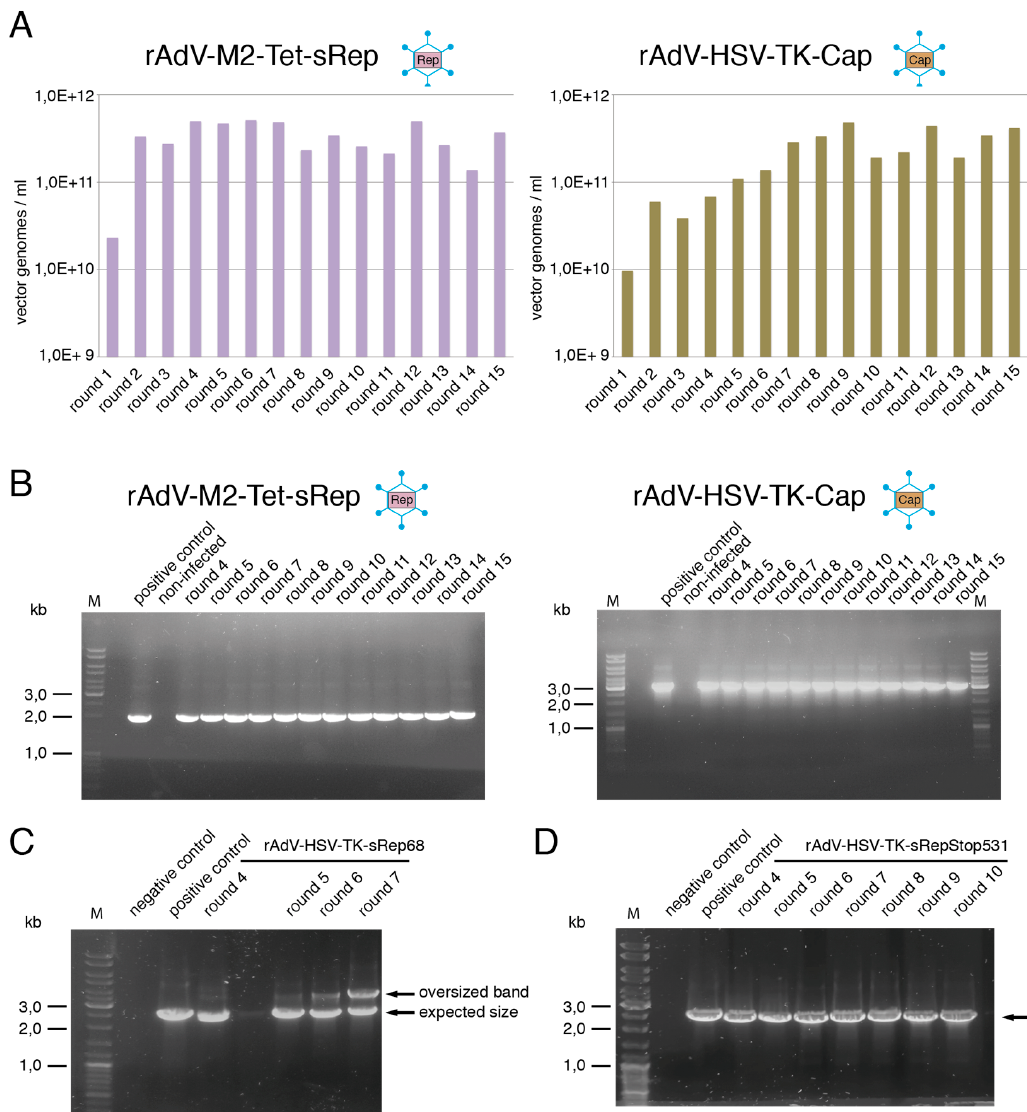
Figure 7. Genomic stability of rAdV used in rAAV packaging. ( A ) and ( B ) rAdV-M2-Tet-sRep and rAdV-HSV-TK-Cap were amplified in HEK293 cells over 15 round as described in the methods section. ( A ) Determination of genomic rAdV titers. ( B ) Analysis of the genomic integrity by PCR-amplification with oligonucleotides binding at the very ends of the respective transgene cassette. The pAdEasy plasmids used for generation of the corresponding rAdVs were used as positive controls. ( C ) and ( D ) Analysis of the transgene cassette in supernatants from different amplification rounds of ( C ) rAdV-HSV-TK-sRep68 and ( D ) rAdV-HSV-TK-sRep-Stop531. The oligonucleotides used for PCR amplification bind within the adenoviral sequences flanking the transgene cassette in the pAdEasy plasmids, which were also used as positive controls.